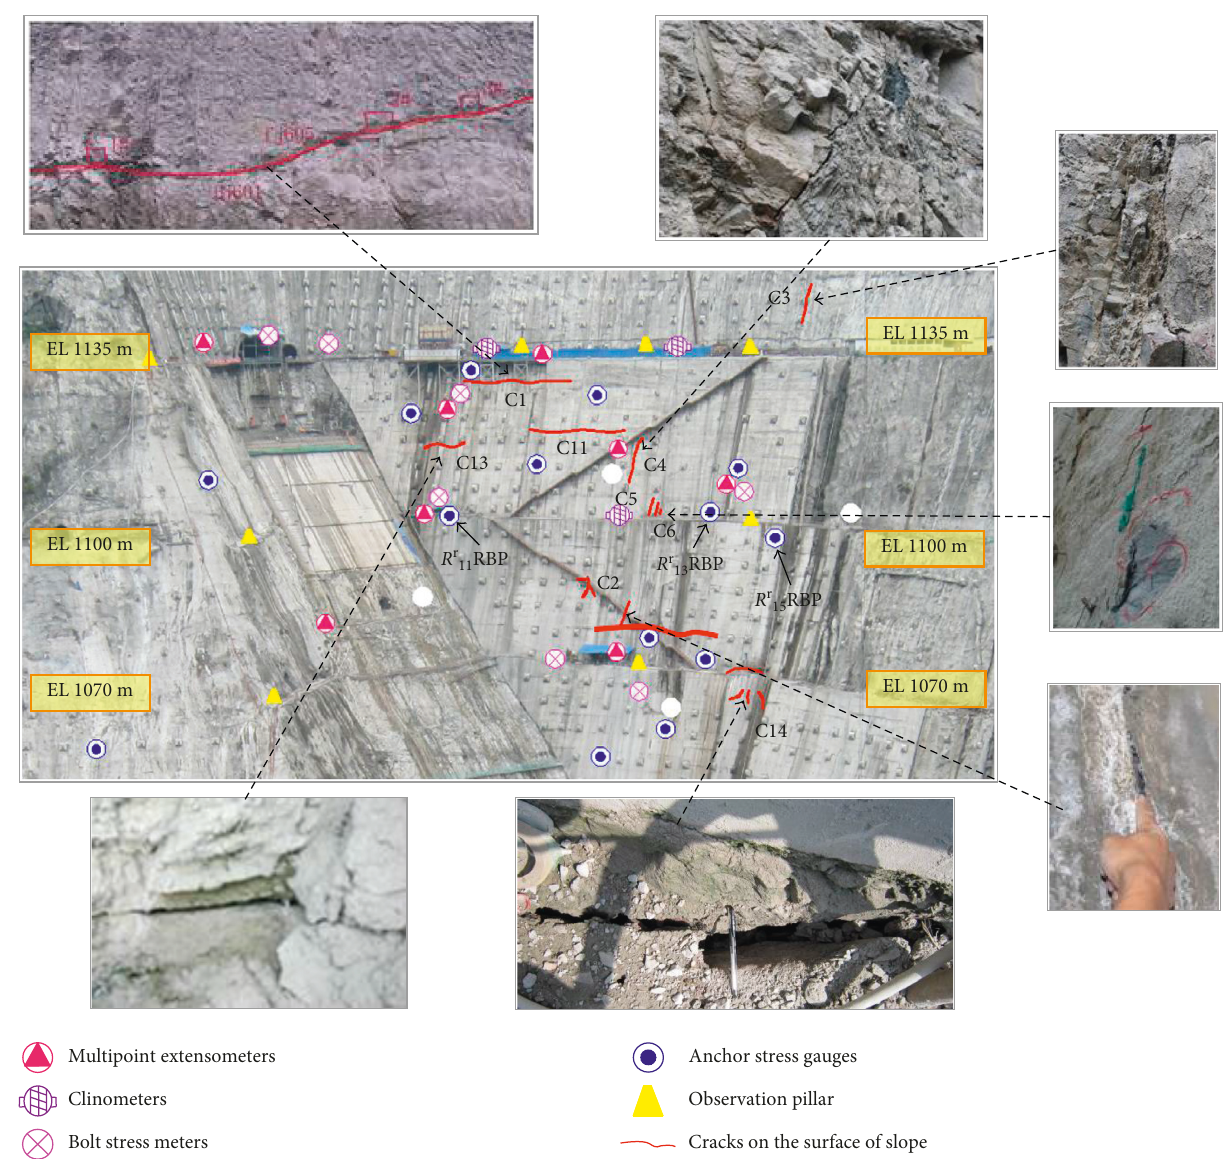
Figure 3: Macroscopic crack positions and layout of conventional monitoring instruments (different symbols denote different surveying instruments and the solid lines represent